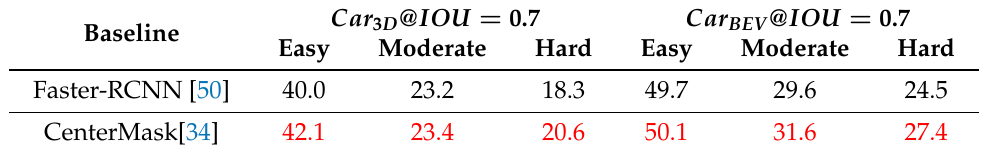
Table 7. Ablation study on object segmentation with the “car” category of the KITTI validation subset. Baseline